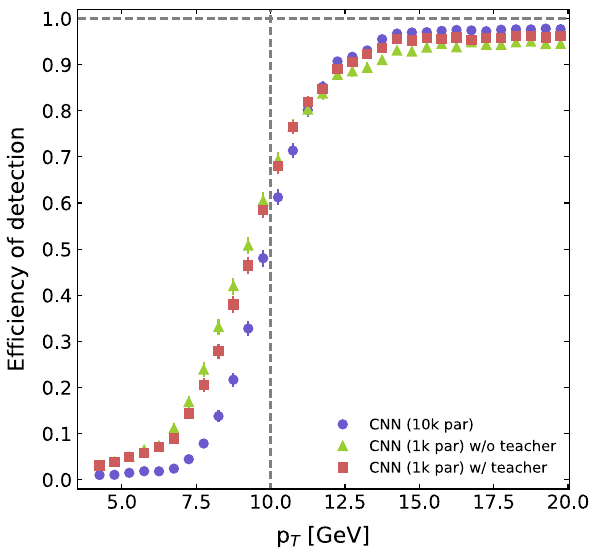
Fig. 9 Efficiency curves (realized as for Fig. 6). Statistical uncertain- ties computed as binomial confidence intervals are shown as well. If not visible, they’re smaller than the markers size. Here in indigo (cir- cles) the performance of the Teacher model. In light green (triangles) the performance of the Quantized Student (4 bits per weight) trained without any help from the Teacher. In red (squares) the performance of the Quantized Student (4 bits per weight) trained with hints from the